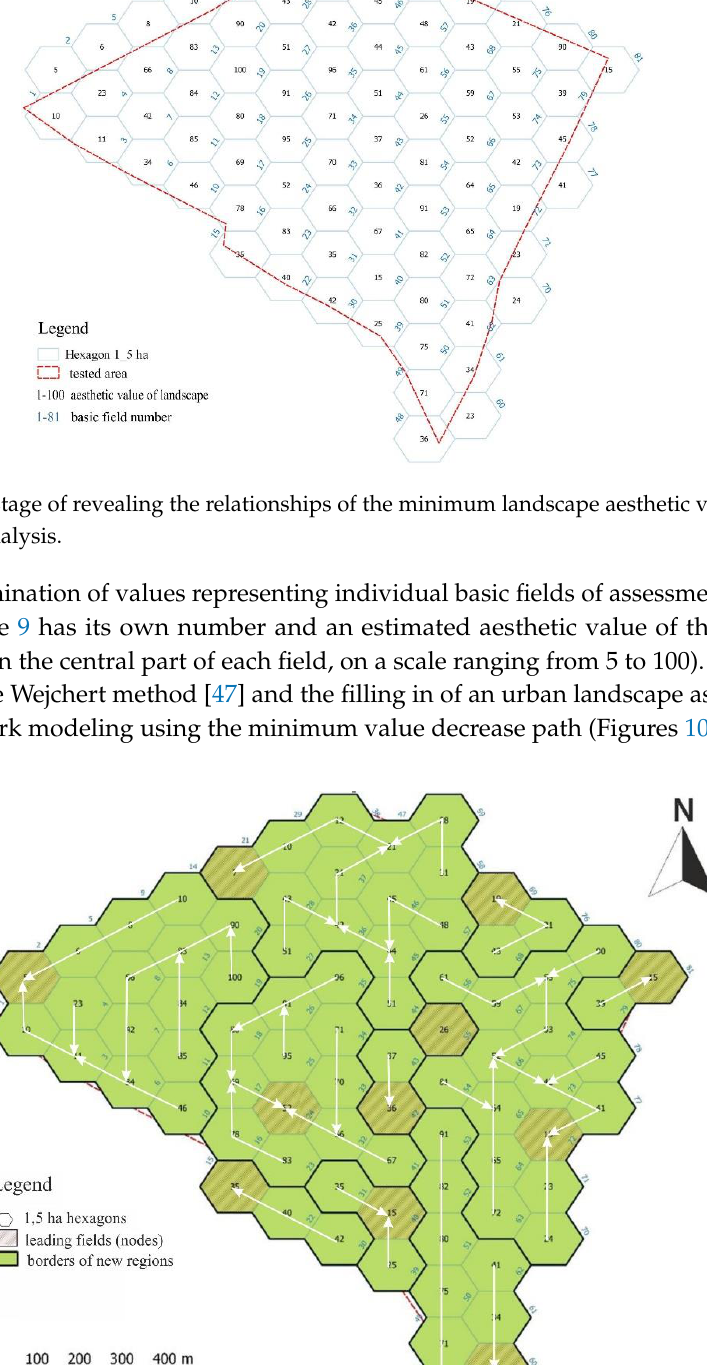
Figure 9. The area of analysis. Hexbin map of aesthetic value needed for network modeling. Source: Own analysis in QGis and based on Open Street Map data.